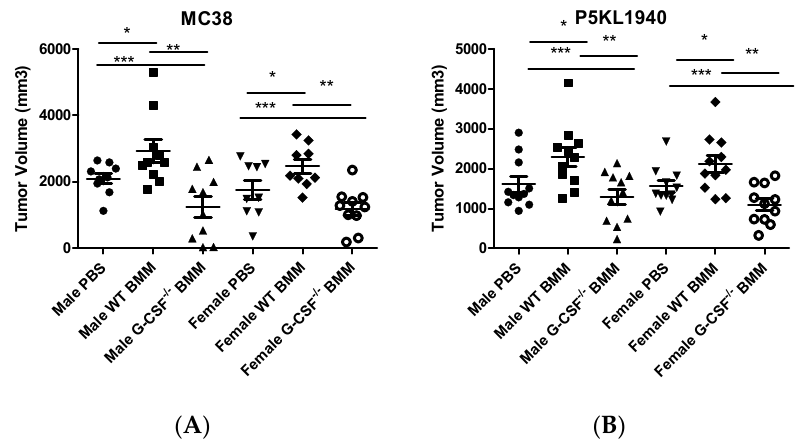
Figure 4. Adoptive transfer of WT or G-CSFR − / − BMMs in ( A ) MC38 or ( B ) PK5L1940 tumor-bearing mice. In both tumor models, injection with G-CSFR − / − macrophages significantly reduces tumor volume in male and female mice. n = 10; * p , ** p , and p *** ≤ 0.05 in comparing different mouse groups.